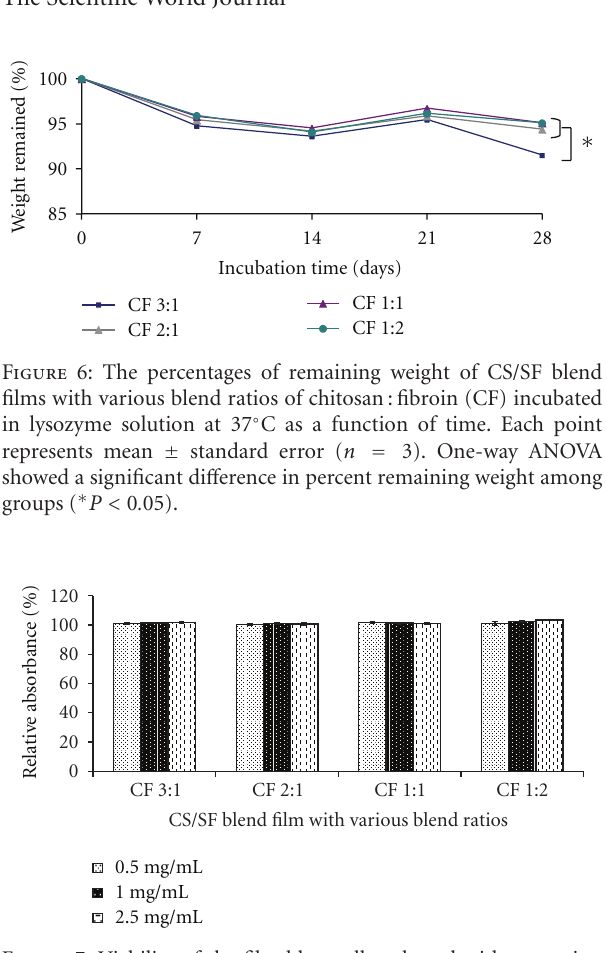
Figure 7: Viability of the fibroblast cells cultured with extraction media from di ff erent blend films. Data represent mean ± standard error ( n = 3) (CF: chitosan: fibroin